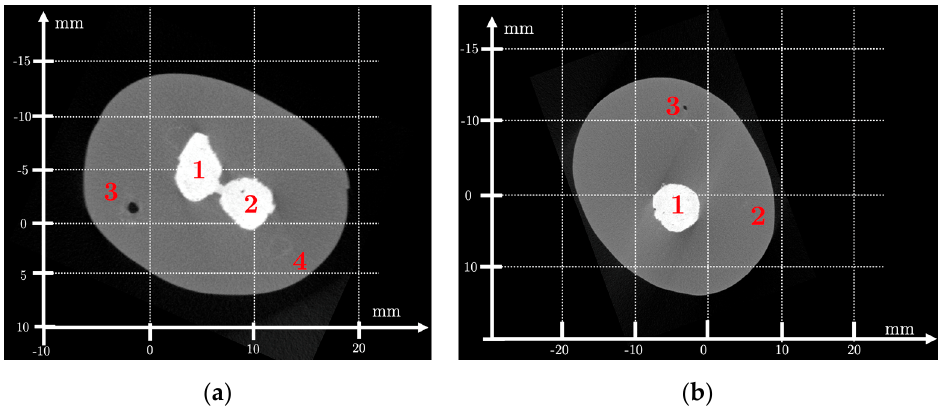
Figure 2. X-ray computed tomography ( µ CT) of the newborn arm phantom (True Phantom Solutions) at H1 = 6 cm ( a ) and H2 = 14 cm ( b ) from the tip of the hand. Size: 1840 × 1456 pixels 2 ; resolution: 30 µ m. Legend H1: (1–2) bones, (3–4) blood vessels. H2: (1) bones, (2–3) blood vessels.